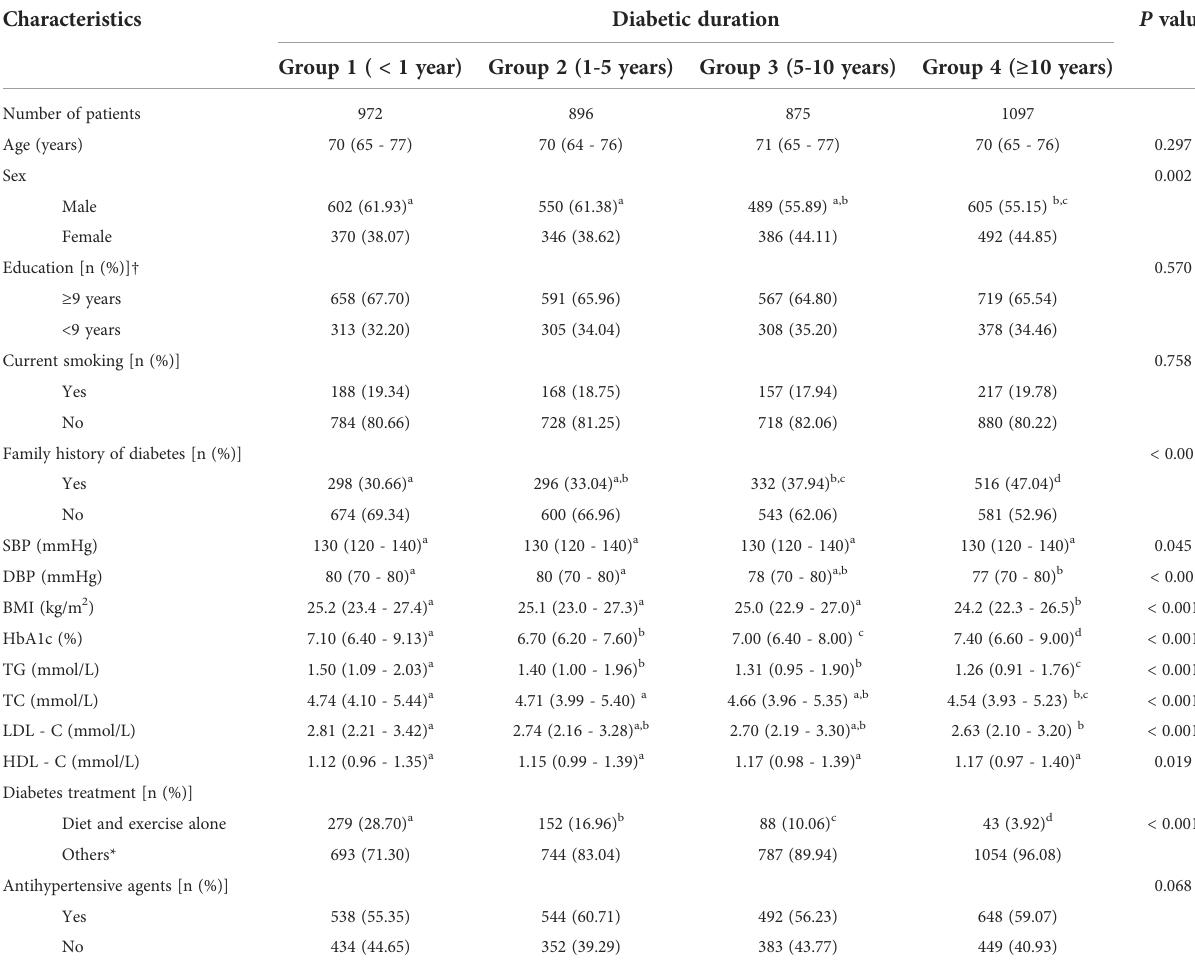
TABLE 1 Characteristics of elderly T2DM patients with different diabetic durations.